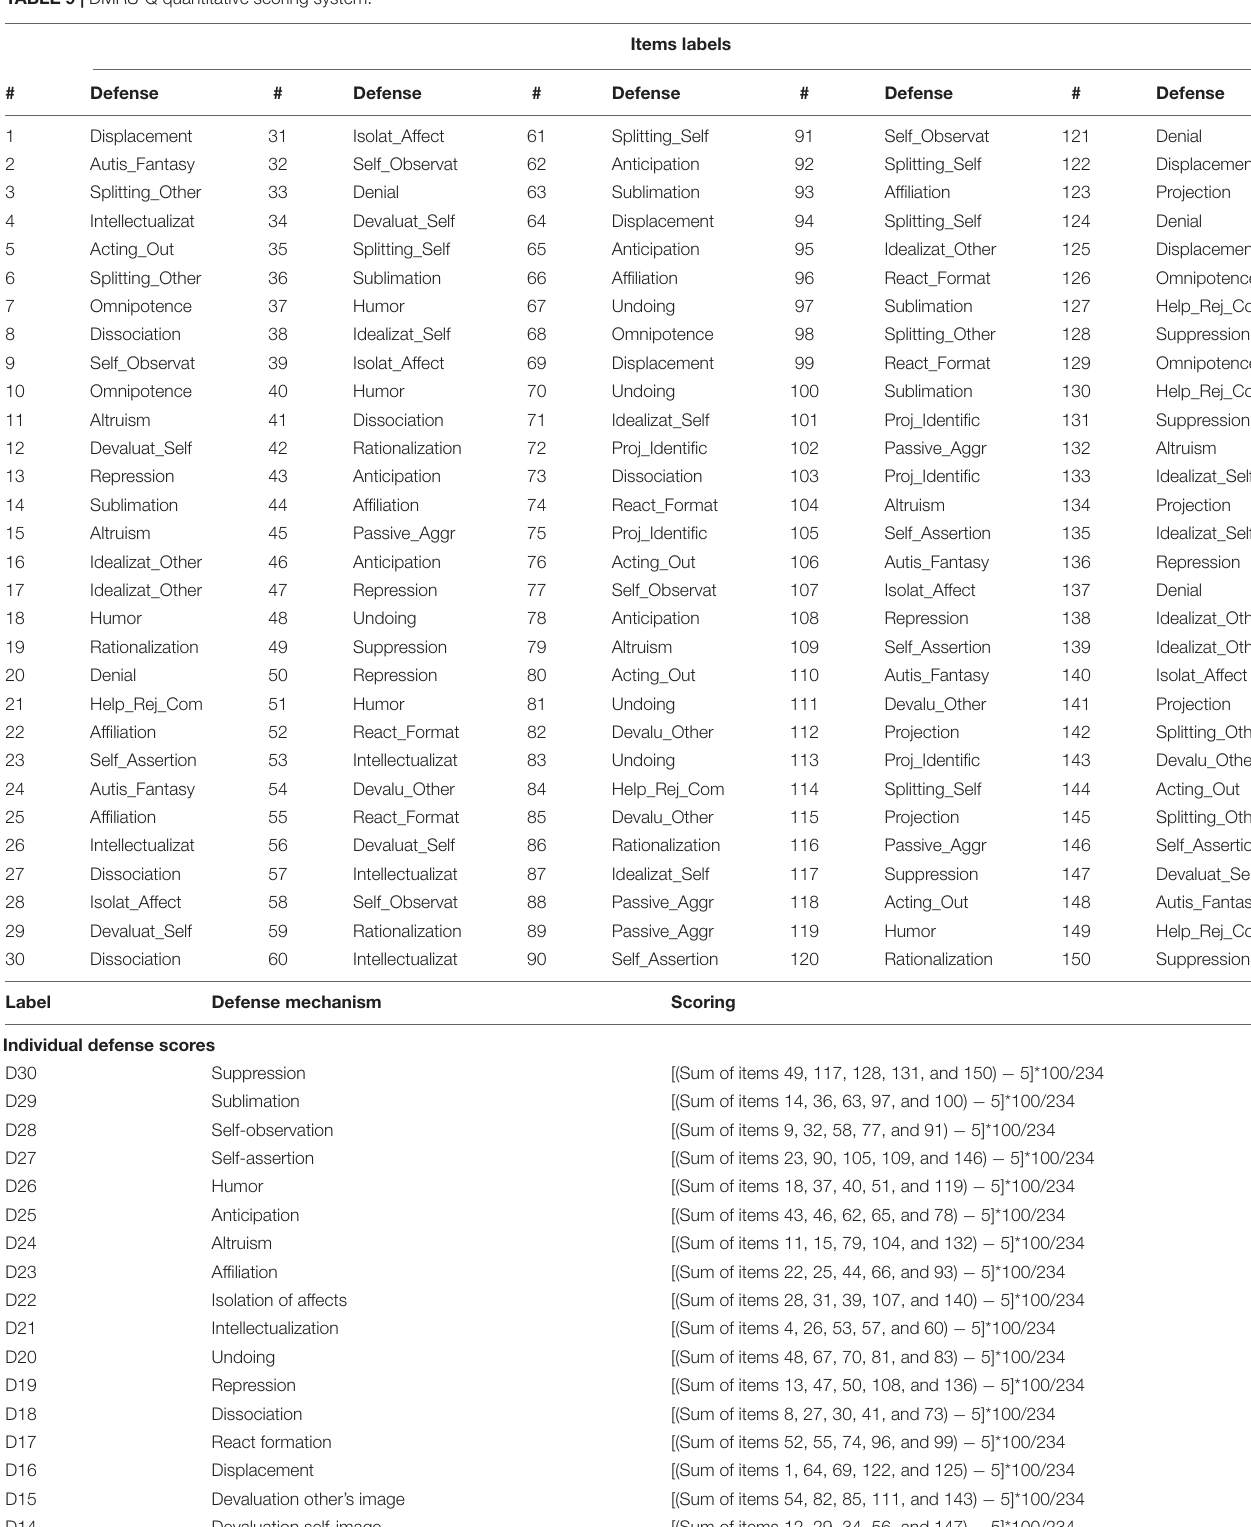
TABLE 9 | DMRS-Q quantitative scoring system.